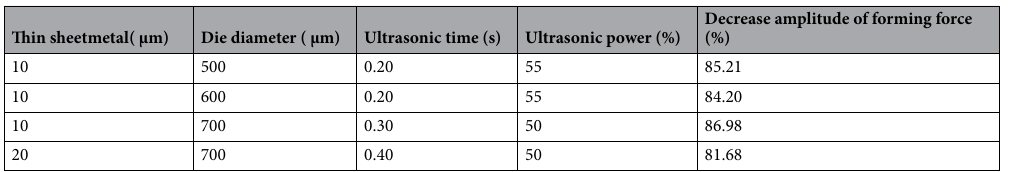
Table 5. Maximum drop of ultrasonic on forming force of thin sheetmetal punching.